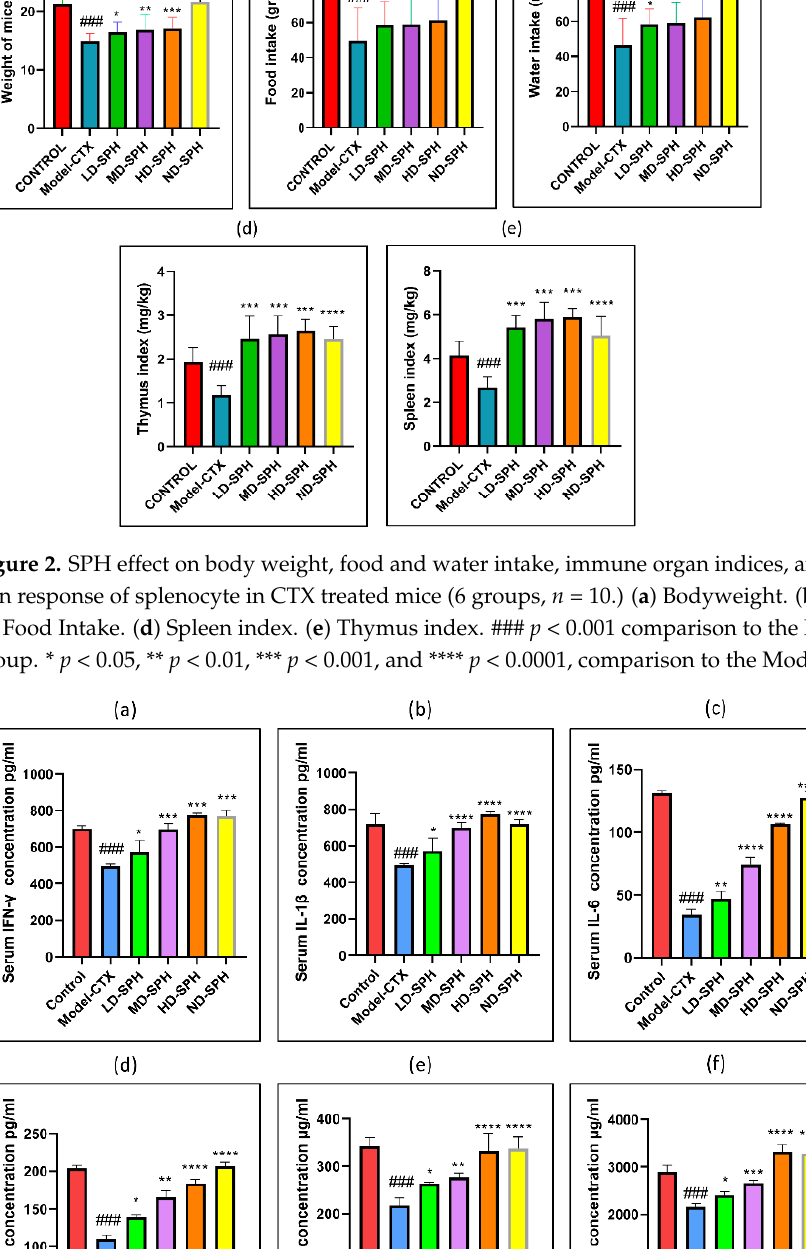
Figure 4. Relative expression of mRNA in colon tissues: ( a ) Mucin-2, ( b ) Zo-1, ( c ) Occludin, and ( d ) claudin-1, mRNA levels were standardized against Beta-actin expression, and as shown the mean ± SD fold increase compared with the control group. ### p < 0.001 comparison to the Normal con- trol group. * p < 0.05, ** p < 0.01, *** p < 0.001, and **** p < 0.0001, comparison to the Model-CTX group.